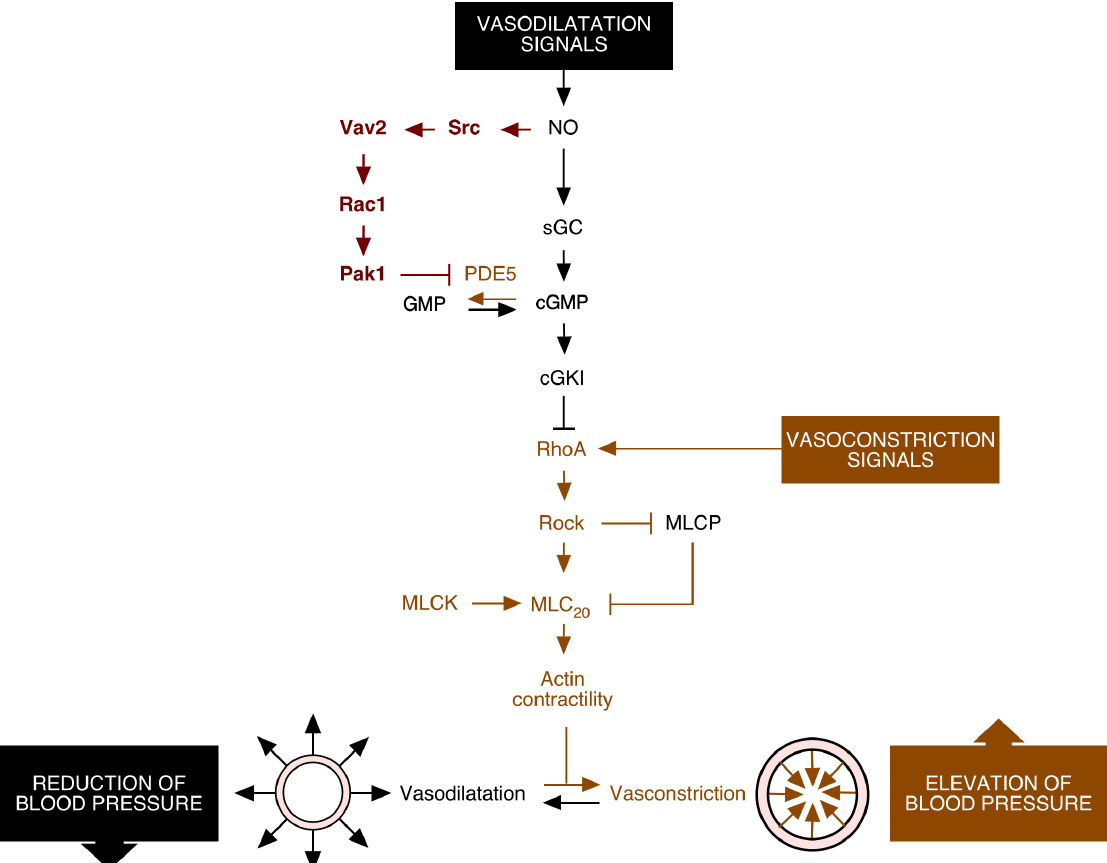
Figure 2. Schematic representation of the Vav2–Rac1-dependent pathway promoting blood vessel vasodilatation (red color). The previously known signaling elements of the NO signaling route in vSMCs are shown in black. The vasoconstriction pathway is shown in brown. Activation steps are indicated by arrows. Inhibitory steps are indicated by blunted lines. See further details in main text. Abbreviations used are: sGC, soluble guanylate cyclase; cGKI, cGMP–dependent protein kinase type I; GMP, guanosine monophosphate; MLCK, MLC 20 kinase. The rest of the abbreviations have already been described in the main